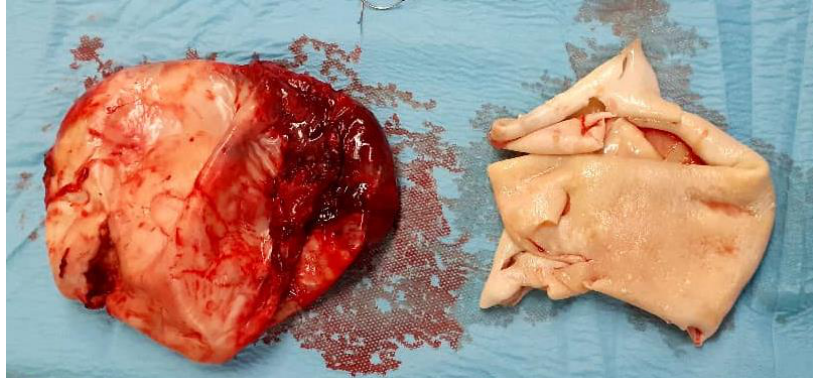
Figure 2: The pericyst lesion was completely excised after removing the cyst membrane in left lung.